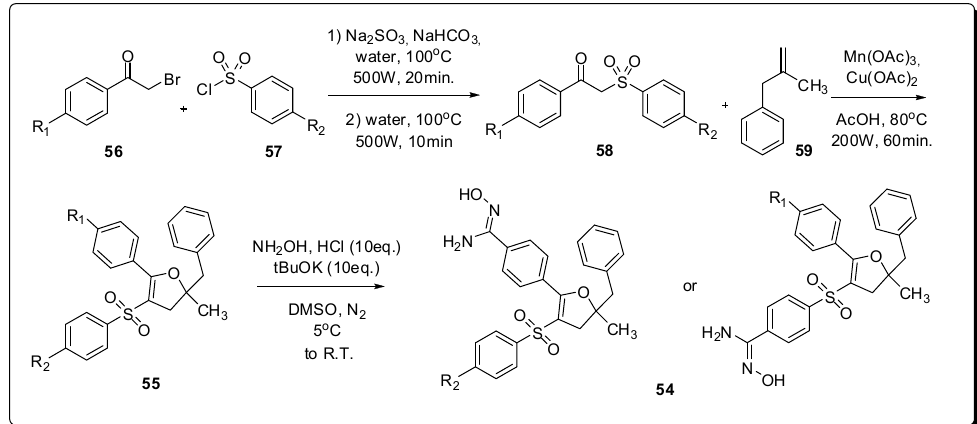
Figure 18. New series of monoamidoxime